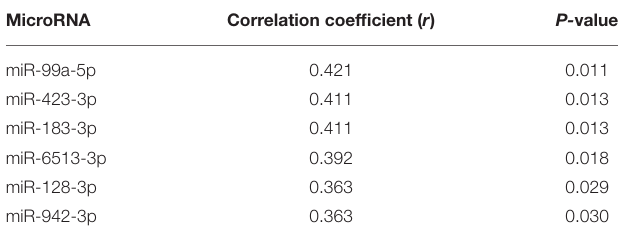
TABLE 3 | Correlation analysis for worsening HF (Spearman rank